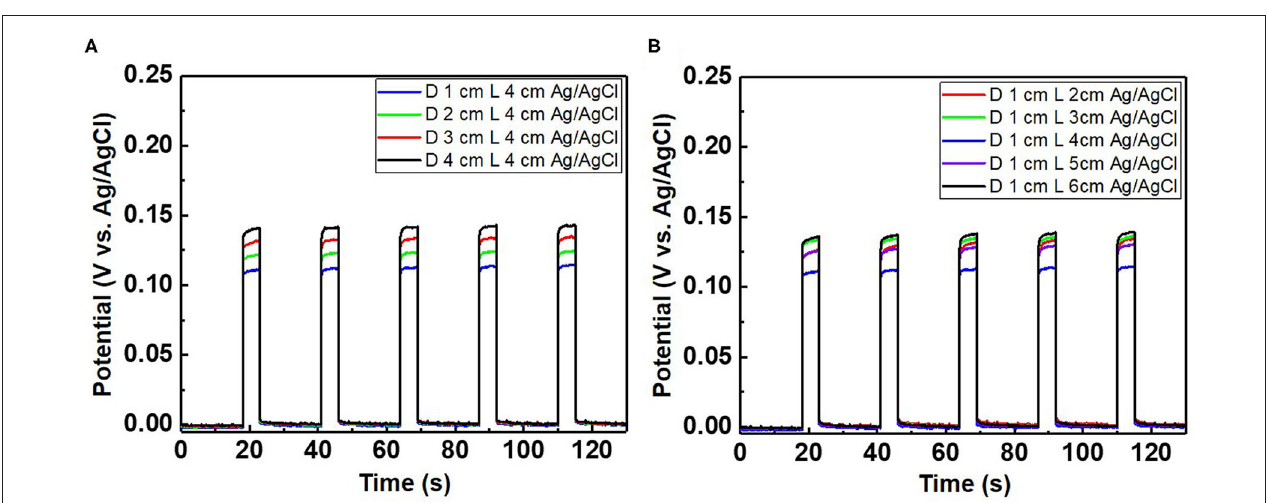
FIGURE 8 | Potential difference of the chloride ion sensor as a function of (A) the distance (D) between the Ag/AgCl wire and diatomite ceramic membrane with a fixed wire length (L) of 4cm and (B) various wire lengths with a fixed distance between the Ag/AgCl wire and diatomite membrane. The applied current pulse for chloride sensing is fixed at 1mA, and the electrolyte comprises 300mM KCl and 0.5M KNO 3 .